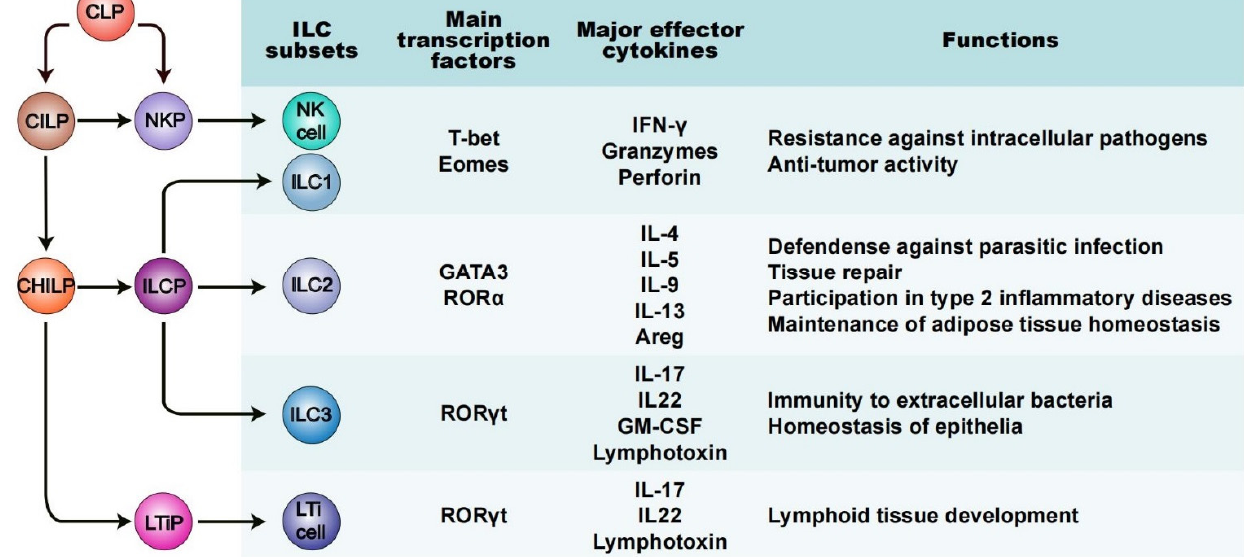
Eomes, or both, to achieve development and expressing IFN- γ as their principal cytokine output [47,48]. The difference is their discrepant developmental pathways and functional features. NK cells develop via NKPs, while ILC1s, like the other two “helper” ILCs, de- velop via ILCPs. In addition, ILC1s are tissue-resident cells and express only low levels of perforin, with less cytotoxicity [13,49]. ILC2s are defined by the expression of TFs GATA- binding protein 3 (GATA3) and retinoic acid receptor-related orphan receptor α (ROR α ), as well as the output of Th2 cytokines, including interleukin (IL)-4, IL-5, IL-9, IL-13 and the epidermal growth factor amphiregulin [50,51]. In addition to showing a response to parasitization [52], ILC2s are also involved in tissue repair and metabolic processes by type 2 immune responses [53–55]. ILC3s are the innate counterpart of Th17 cells. In mice, ILC3s rely on the TFs ROR γ t to develop and perform their functions and produce cyto- kines IL-17 and either IL-22, granulocyte macrophage colony-stimulating factor (GM-CSF, also known as Csf2), lymphotoxin, or a combination [12,56–58]. ILC3s are abundant in mucosal tissue, where they perform the innate immune response to extracellular patho- gens and develop immune tolerance to intestinal symbionts. Thus, ILC dysfunction may